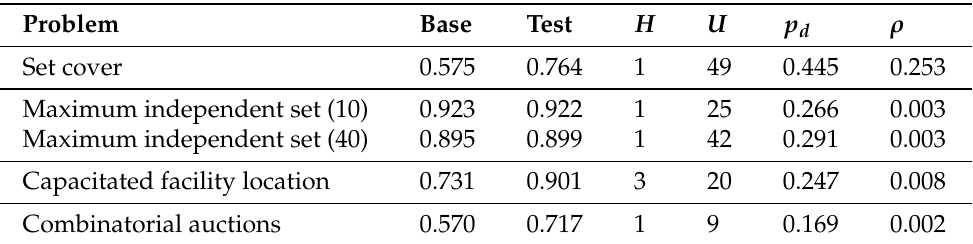
Table 5. ML parameters and prediction results. The baseline accuracy is predicting everything as the majority